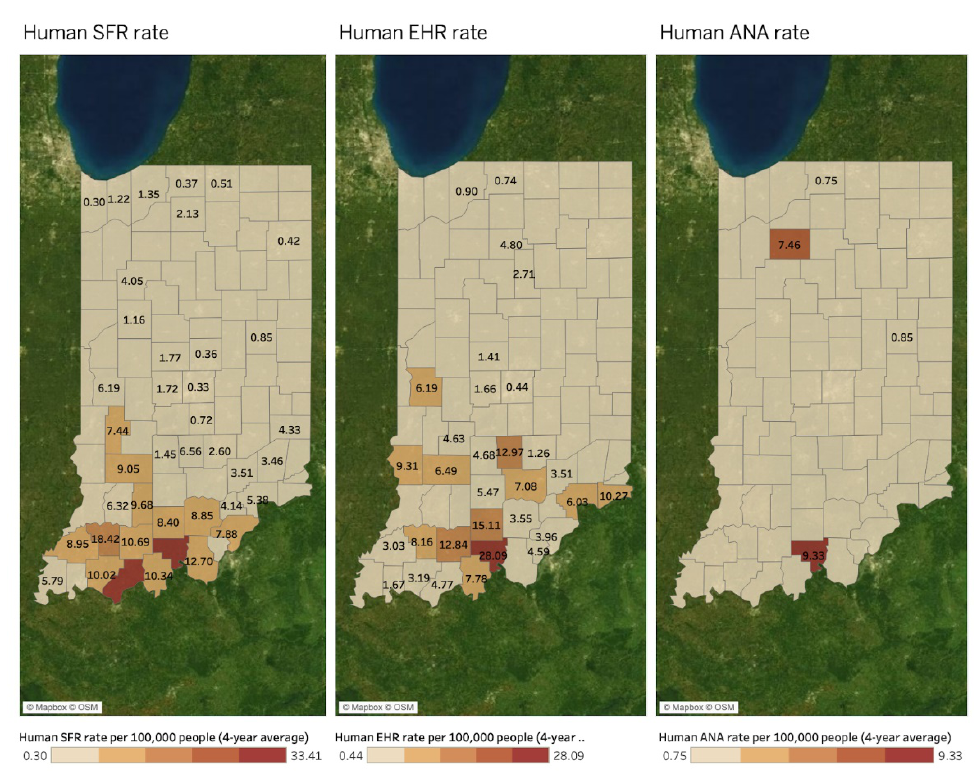
Figure 7. Deer mortality and human SFR, EHR, and ANA rates per 100,000 people by county (4-year average between 2017 and 2020).